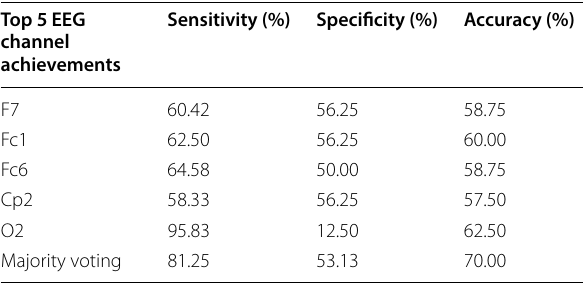
Table 8 Top 5 EEG channel achievements on beta rhythm for HA vs LA classification Top 5 EEG channel